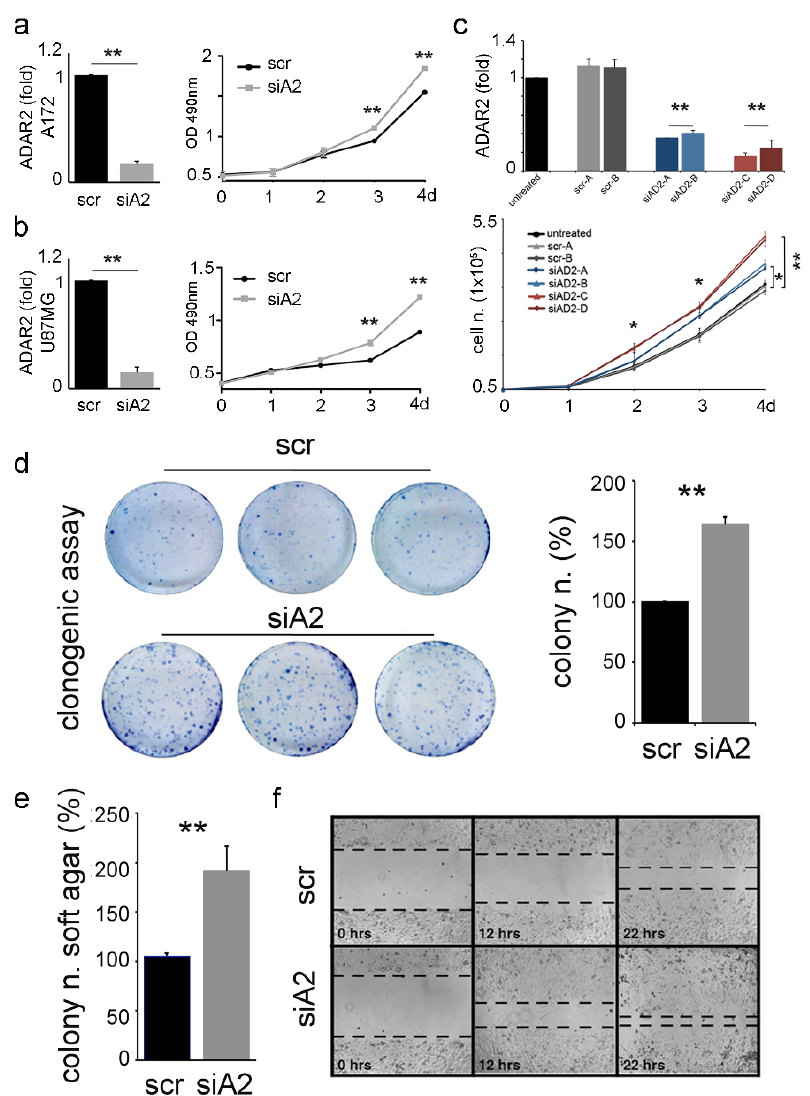
Figure 3. ADAR2 loss promotes proliferation, migration, and anchorage-independent growth of cancer cells. ADAR2 knockdown (qRT-PCR at 96 h, on the left) and cell proliferation (MTS, on the right) are shown in A172 ( a ) and U87-MG ( b ) cell lines. Ct values were normalized to GAPDH